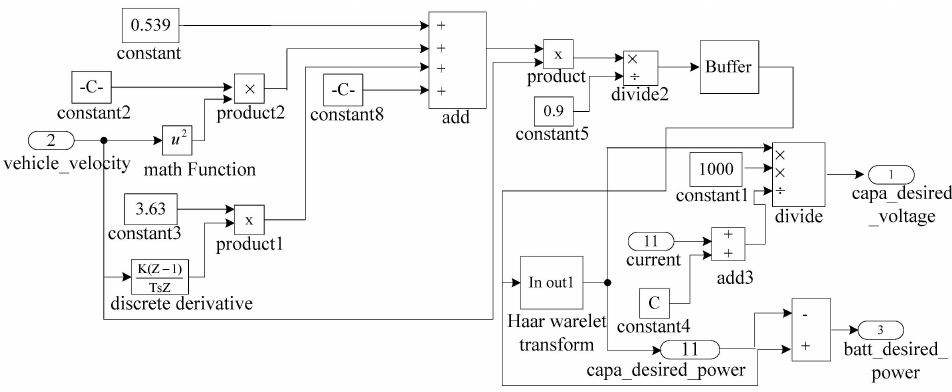
Figure 3. Power distribution process of HESS.